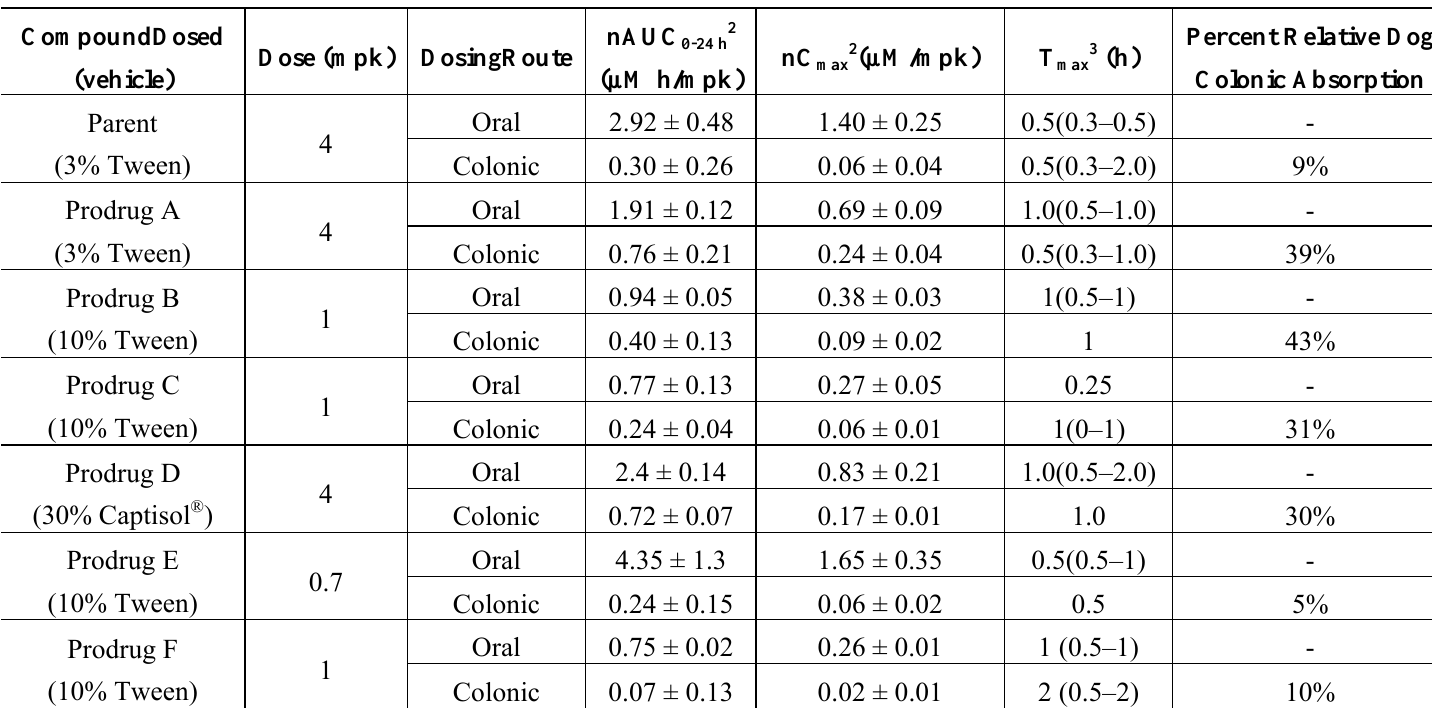
Table 3. Mean [± SE] pharmacokinetic parameters for parent after oral and colonic administration of solutions of the prodrug to fasted Beagle dogs 1